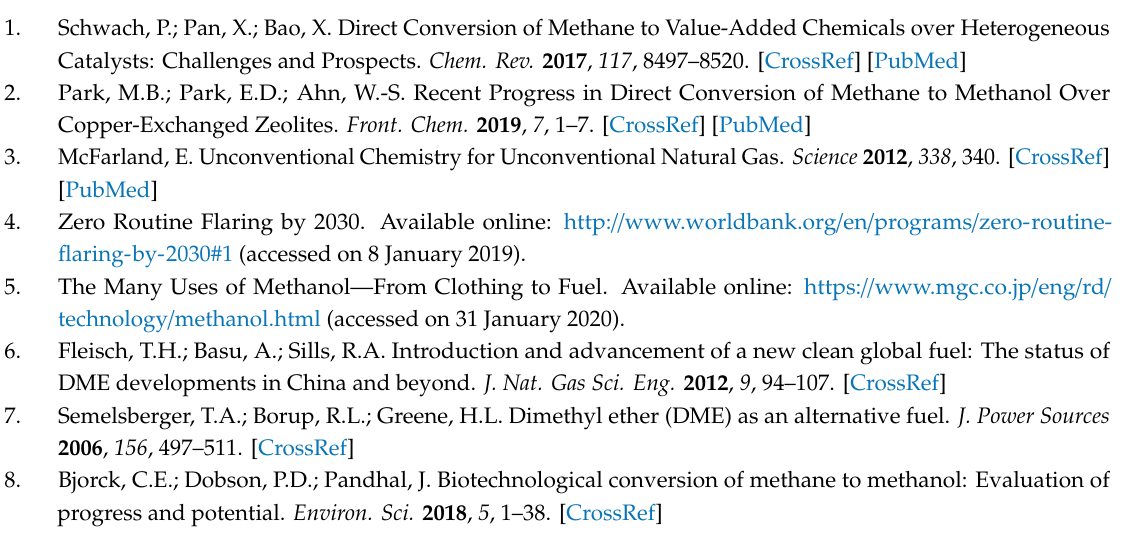
Figure S1: SEM images, Figure S2: PXRD patterns of SAPO-34, Figure S3: PXRD patterns of Cu-SAPO-34, Figure S4: CO 2 production from CH 4 -TPR. Table S1: physicochemical characterization, Table S2: Raman spectroscopy